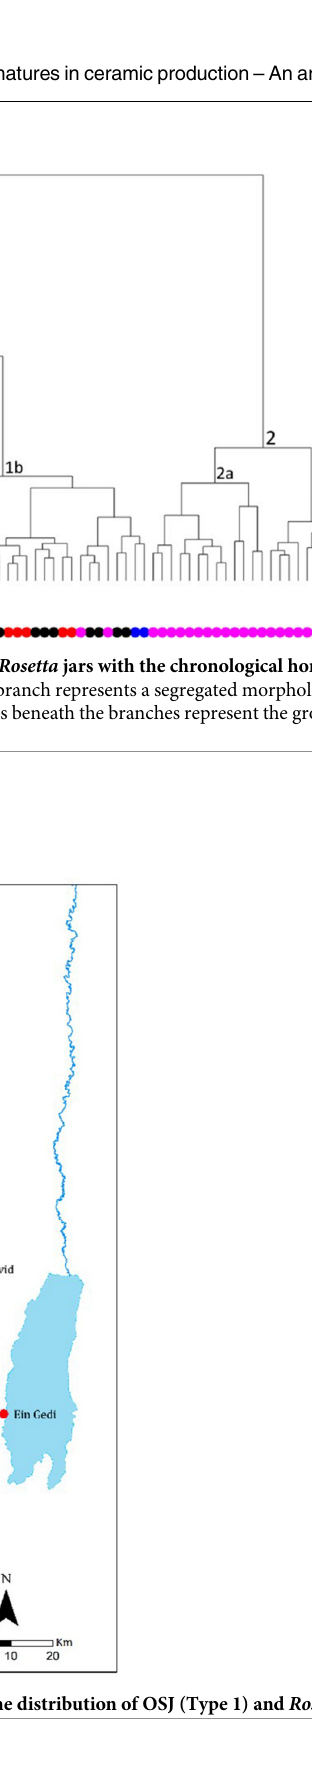
PLOS ONE | https://doi.org/10.1371/journal.pone.0254766 July 26,